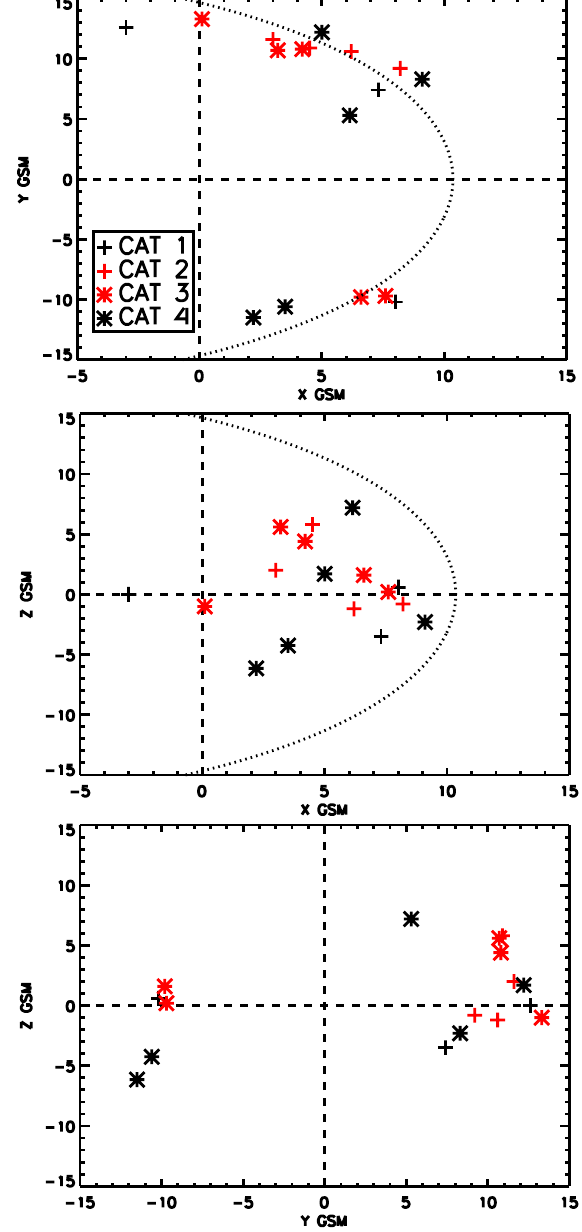
Fig. 3. The location of all the events listed in Table 1 in Geocentric Solar Magnetospheric (GSM) coordinates, subdivided into varying levels of % RO : (Category 1) % RO > 40, (Category 2) 30 < % RO < 40, (Category 3) 10 < % RO < 20% and (Category 4) % RO < 10%.